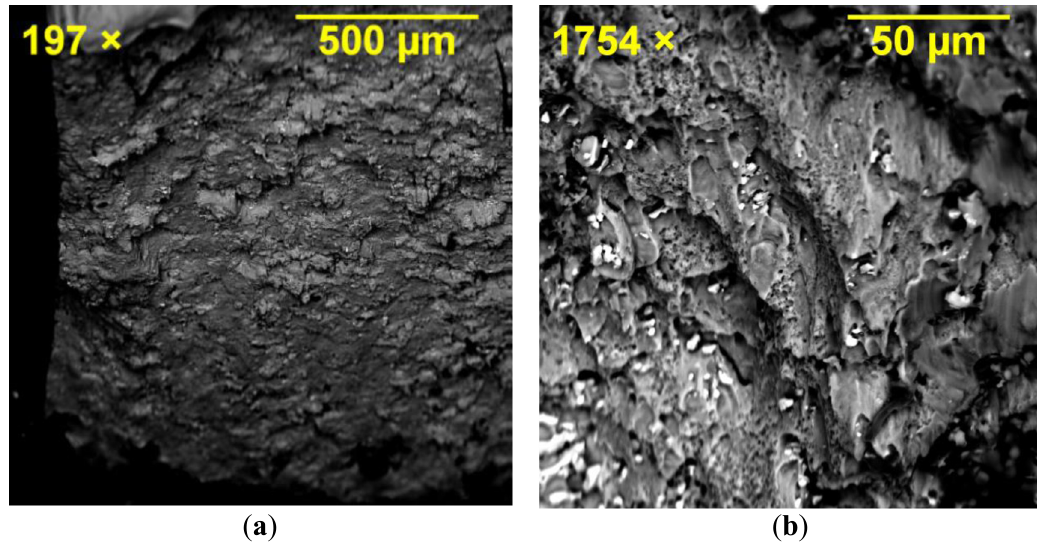
Figure 13. Fracture surface of the middle plate in DW1e1 showing a ductile dimple rupture after failure: ( a ) lower magnification; ( b ) higher